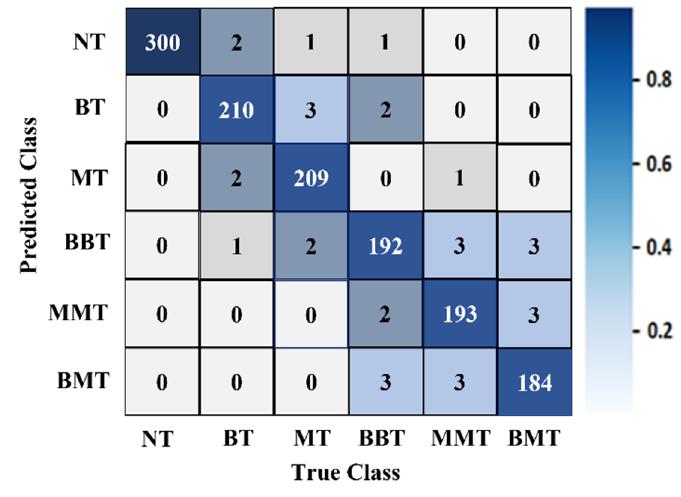
Figure 10. The confusion matrix of the proposed MBINet classification model for the raw RMB brain images.